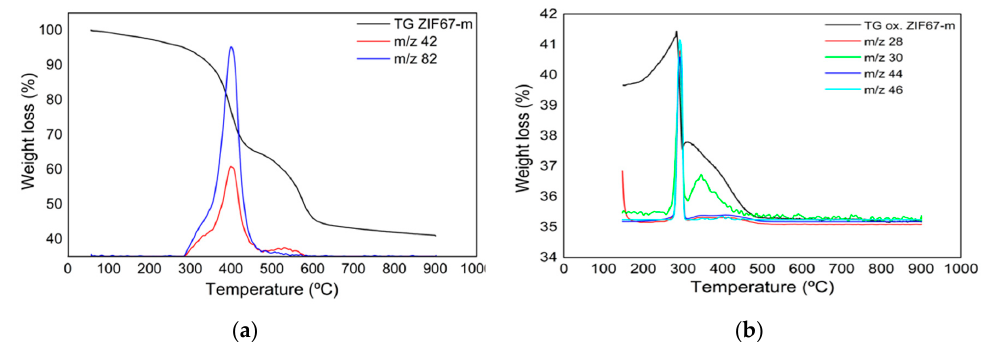
Figure 3. TGA-MS of sample ZIF-67-m. ( a ) In Ar, where m/z 42 is related with the 1,2,4-triazole and m/z 82 is related with 2-methylimidazole; ( b ) in 4:1 Ar:O 2 , where m/z 28 is CO, m/z 30 is NO, m/z 44 is CO 2 , and m/z 46 is NO 2 .